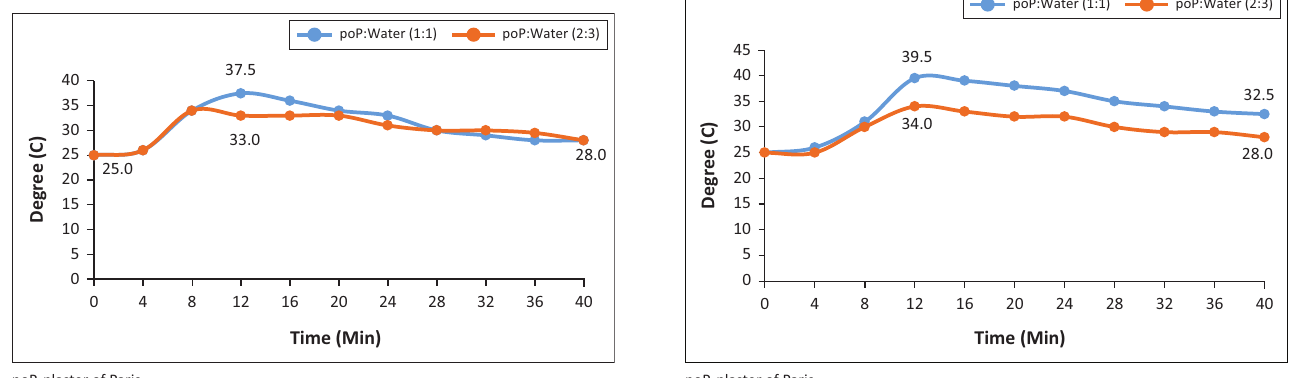
FIGURE 11: 1st recycled temperature change.